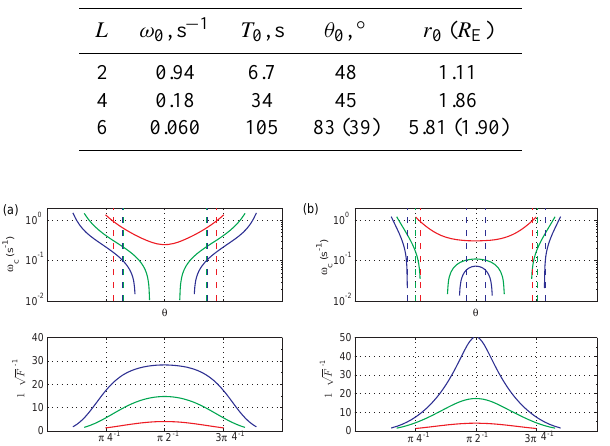
Figure 3. The parameter ω c (with B 0 = 0 . 31 Gauss, a = 6 . 4 × 10 8 cm and ρ e = 7amucm − 3 ) and the amplitude factor as a func- tion of θ for various L values for the compressed-dipole field with (a) φ = 0 and (b) φ = π , respectively. Format is the same as Fig. 1. The broken part of some curves corresponds to ω 2 c < 0.